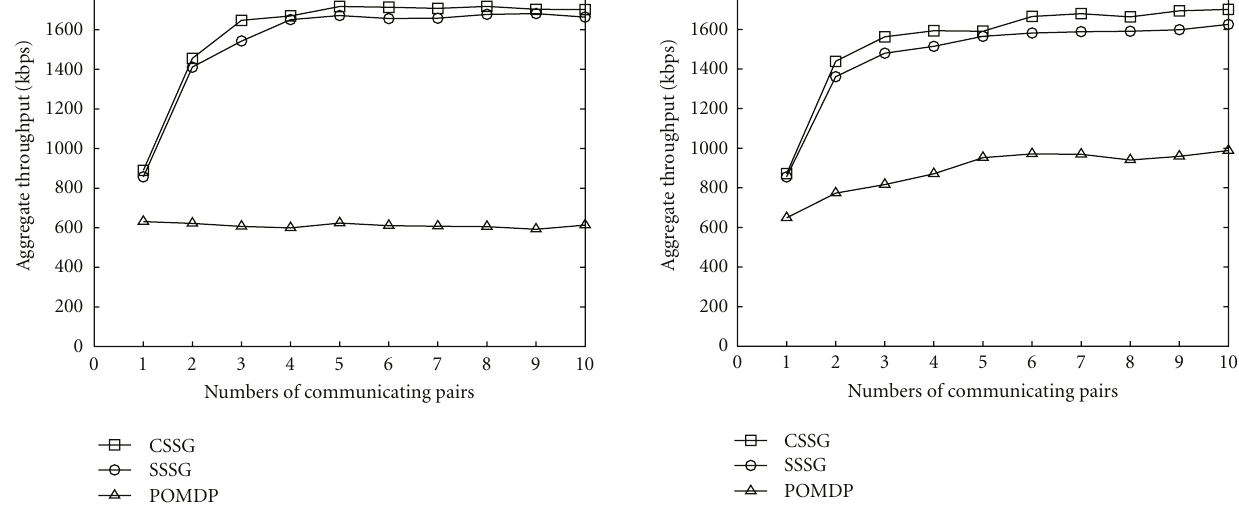
Figure 6: Aggregate throughput. Channel 1: β = 1.0. Channel 2: β = 1.0. Channel 3: β = 1 . 0.